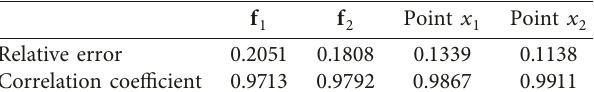
Table 2: The relative error and the correlation coefficient of the . identified F 2